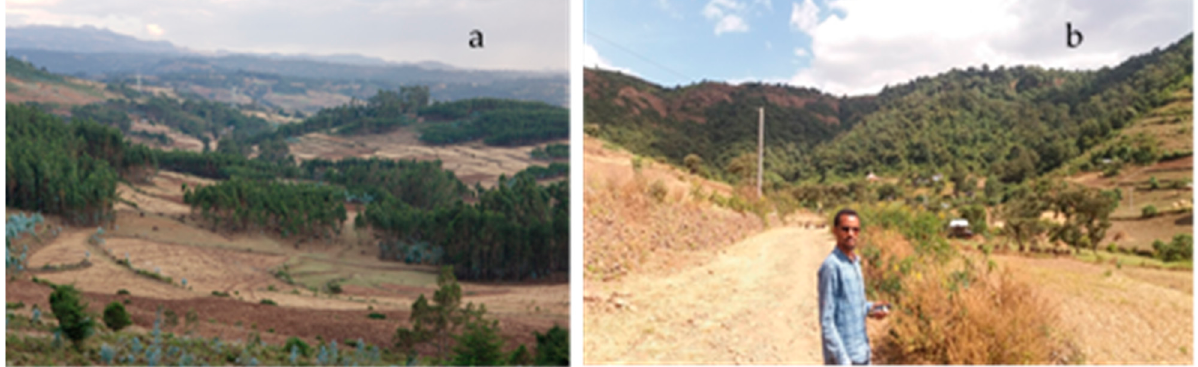
Figure 2. Eucalyptus woodlots encroaching on cultivated fields ( a ) and GPS point data collection ( b ).